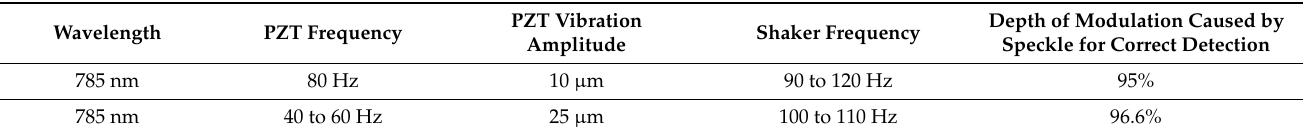
Figure 15. Results of testing of noisy experimental SMI signals with low SNR ( a ) shows the SMI signals (acquired by using experimental setup number 3) with commercial laser diodes emitting at 785 nm with bias current of 76 mA and 36 mA while liquid lens voltage was set to 45 mV for both signals, respectively. ( b ) is the enlarged view of a segment of SMI signal ( c ) shows the correct FD for corresponding laser diode SMI signals Table 2. Specifications of different parameters under which experimental SMI signals were acquired including the estimated depth of modulation, ˆ m , caused by optical speckle.